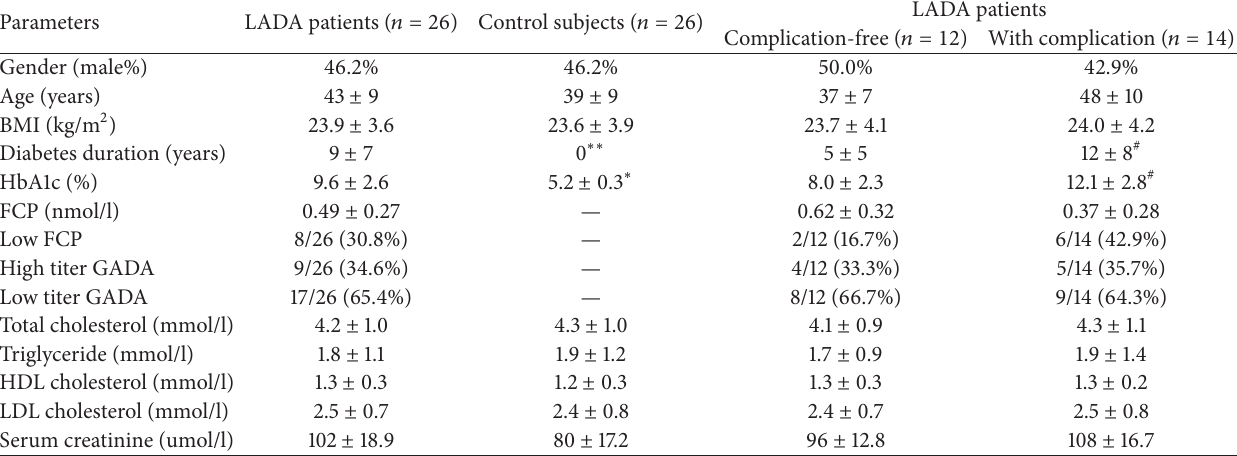
Table 2: Characteristics of the